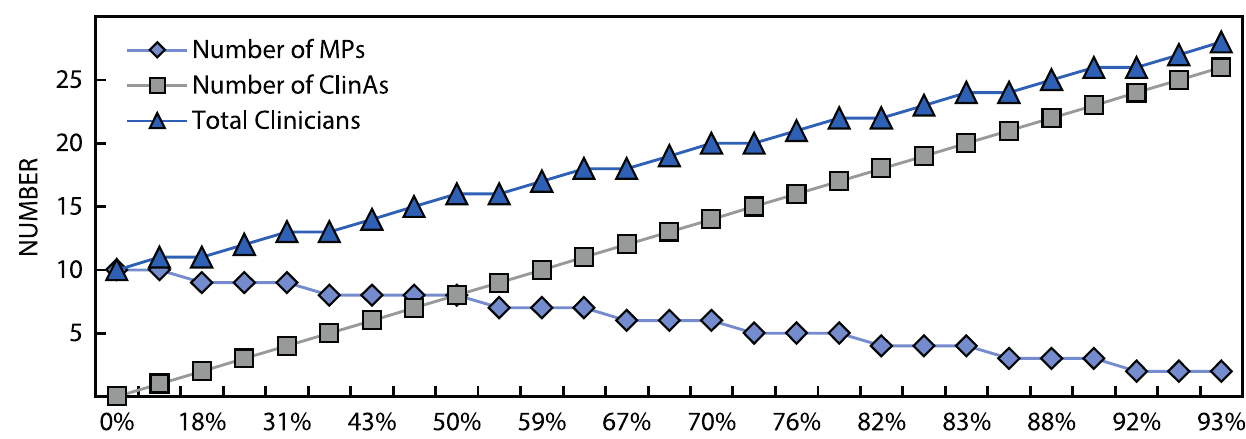
Figure 1: Number of clinicians that can be employed with an annual budget of R 7 million compared with the percentage of Clinical Assistants in the team.